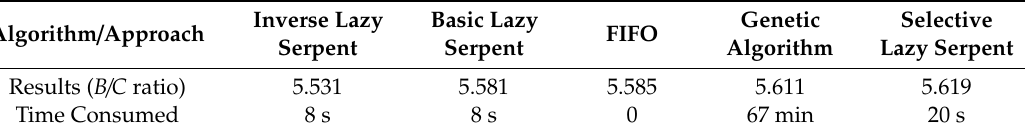
Table 2. Comparison of prioritization models (FIFO, first-in-first-out). Inverse Lazy Basic Lazy Genetic Algorithm / Approach Serpent